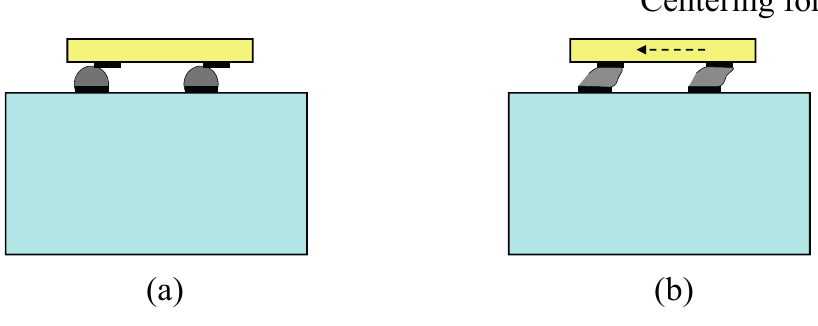
Figure 2. Mechanism of self-alignment: ( a ) misalignment before reflow; ( b ) self-alignment caused by centering force during reflow process.